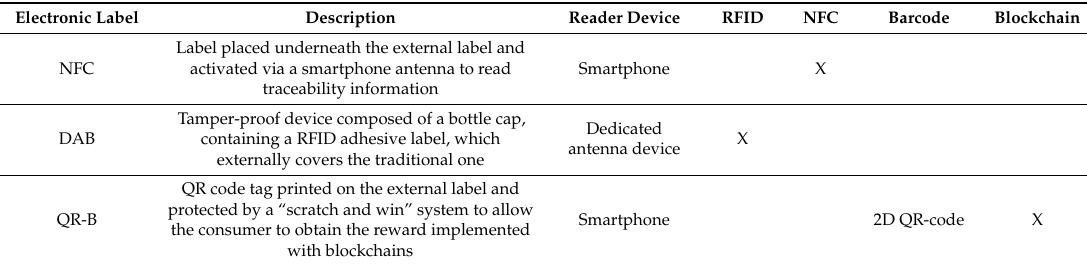
Table 1. Electronic labels used for the